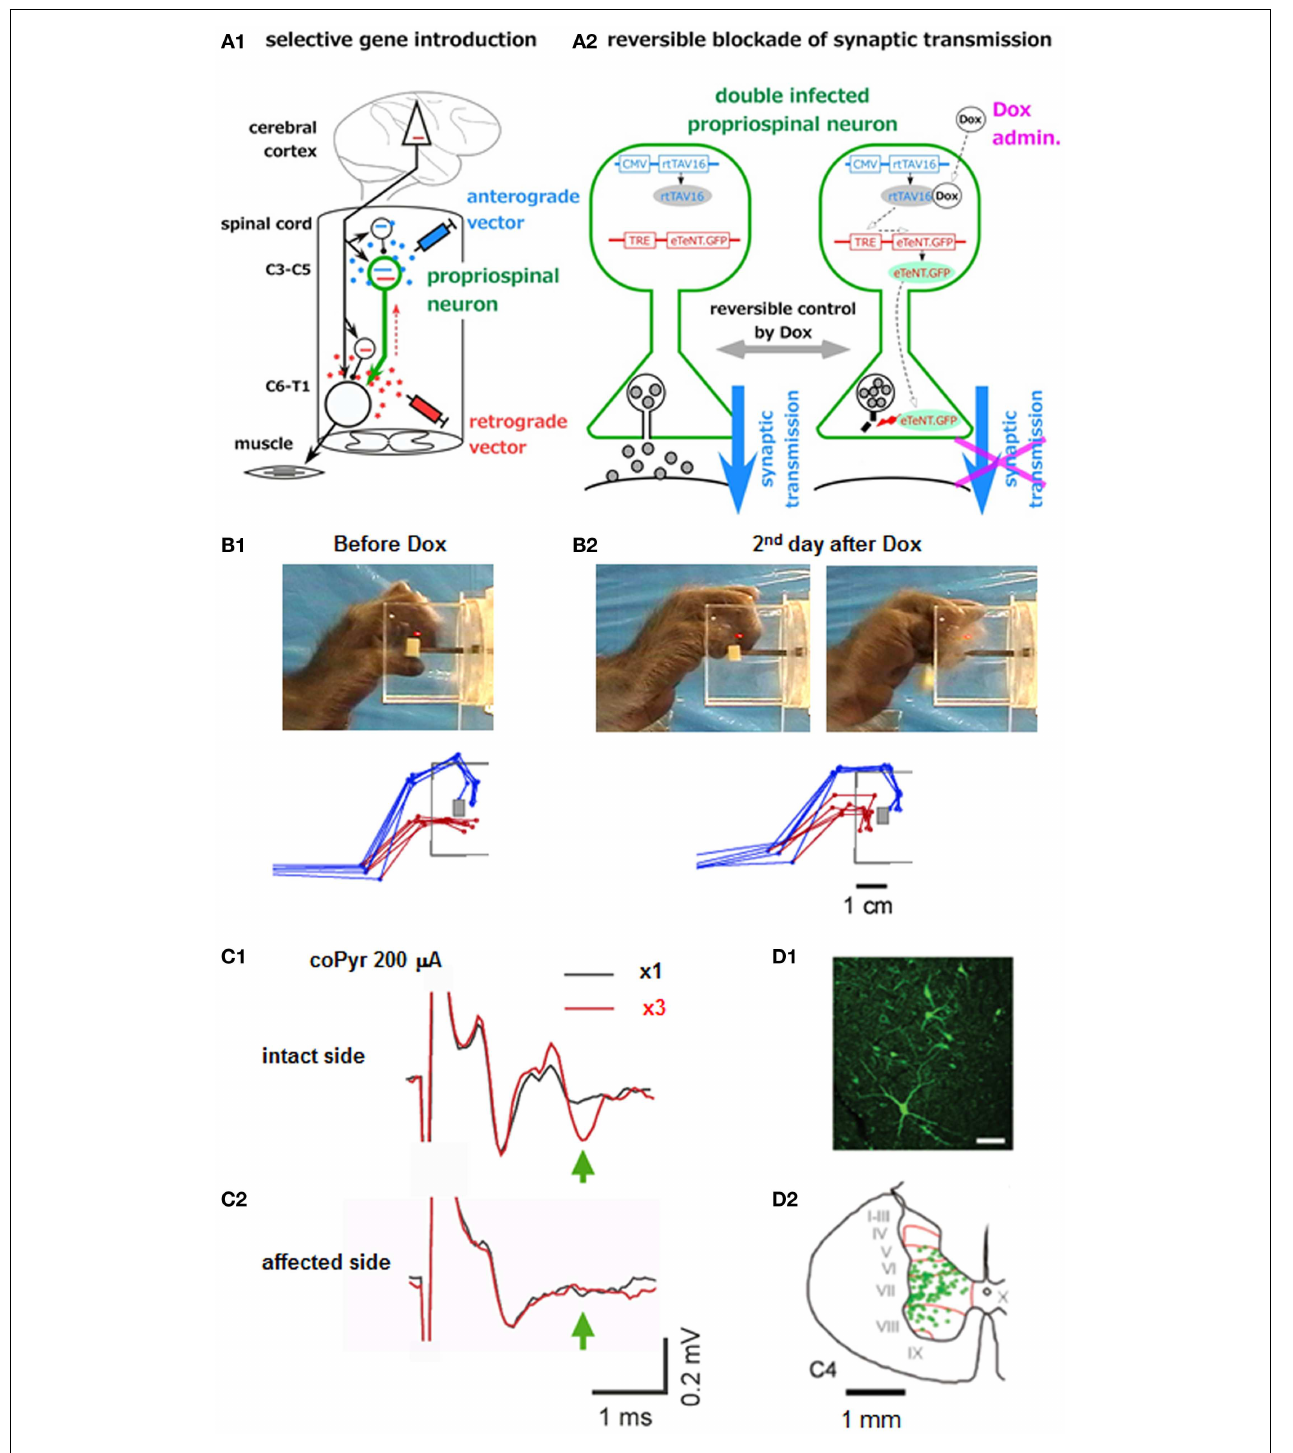
sweet potato. (B2) The same arrangement taken on the second day after the start of Dox administration. (C1) Local field potential in the DR motor nucleus, evoked following the first stimulus of the brainstem pyramid (at 200 µ A) (blue) and that following the third stimulus (red) applied at 300Hz on the intact side. (C2) The same arrangement. On the affected side. (D1) Fluorescent view of the GFP-positive neurons (PNs). (D2) Laminar distribution of the GFP-labeled cells in the C4 segment [modified from Ref.